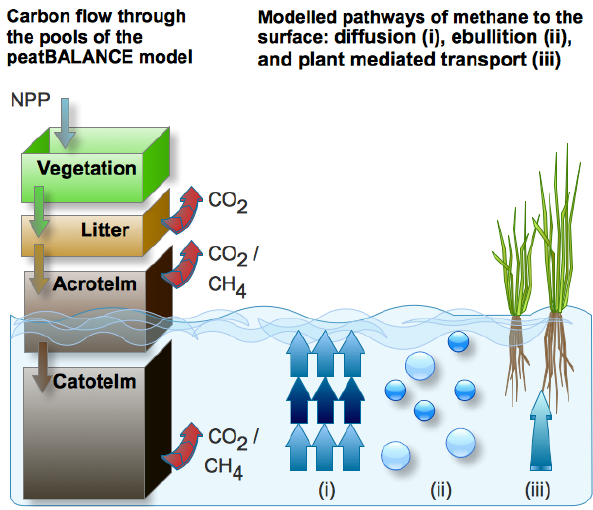
Fig. 1. Diagrammatic sketch of the carbon fluxes in the peatBALANCE model. The transport pathways of CH 4 fluxes are shown at the